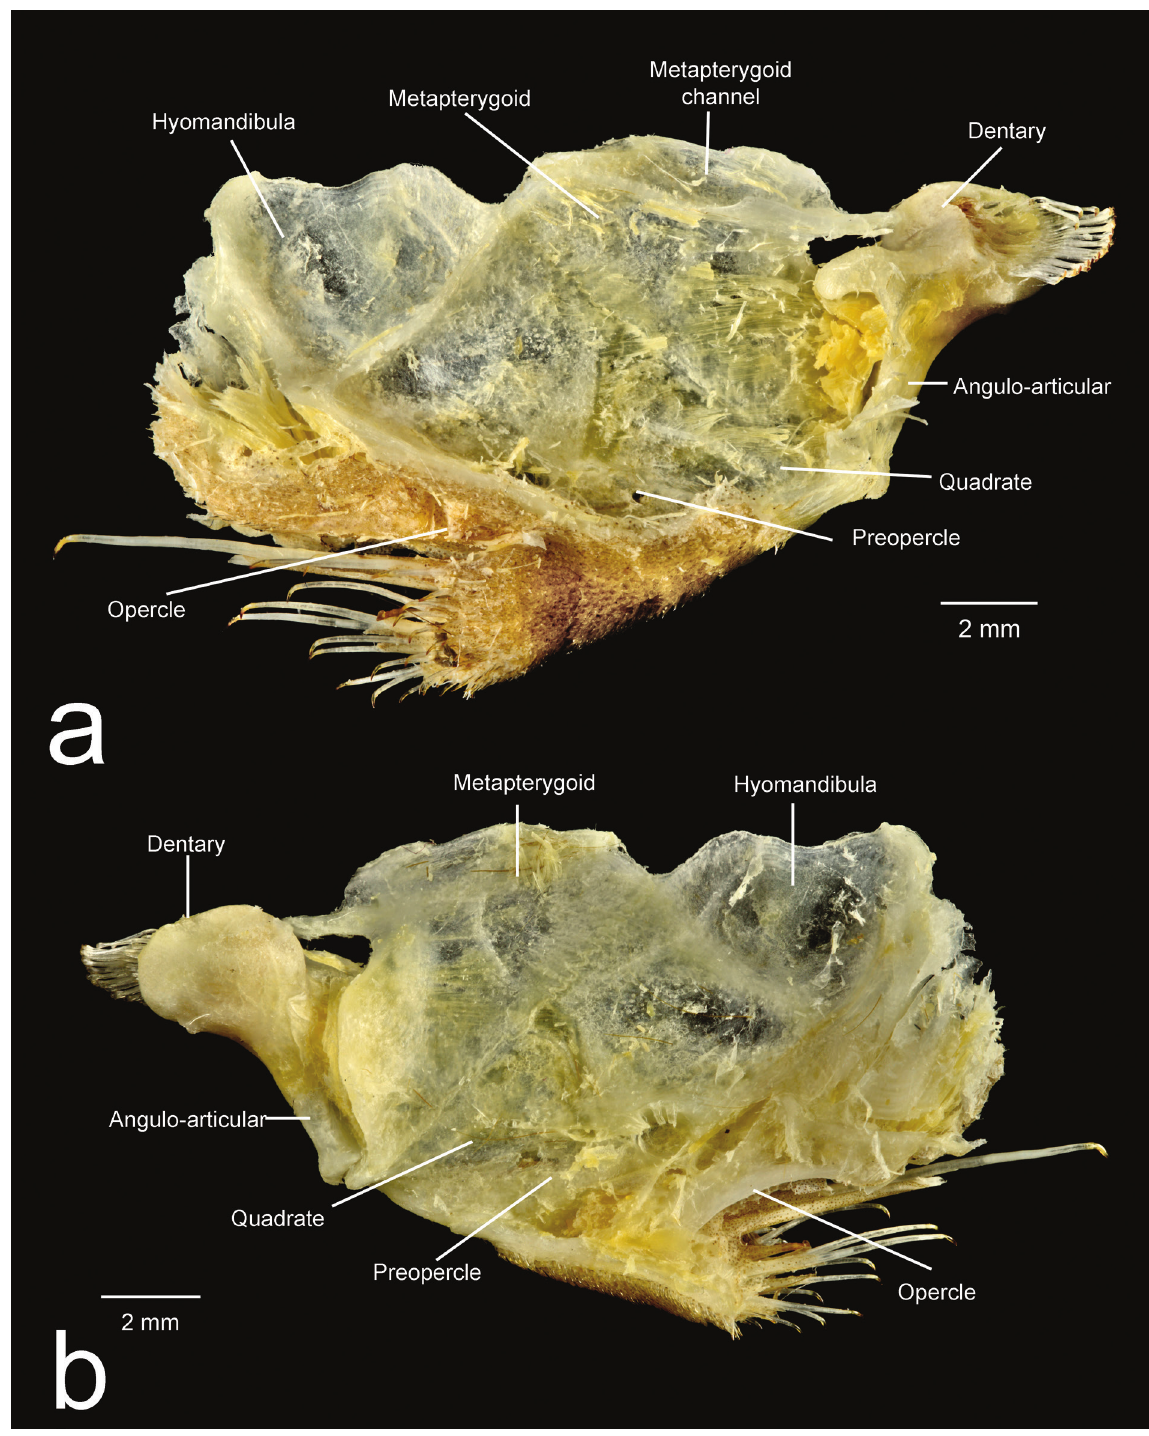
Fig. 8. Suspensorium of Spectracanthicus punctatissimus , MZUSP 108570, 78.2 mm SL. (a) external view and (b) internal view. Scale bars = 2 mm. Image by E.